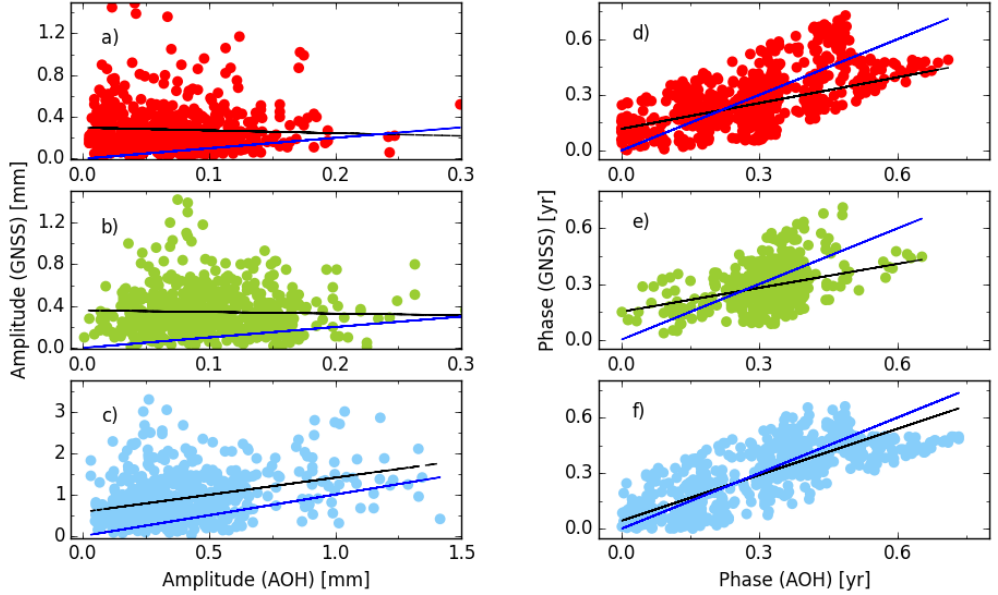
Figure 8. The agreement performance of semi-annual signal between GNSS and AOH, ( a , d ) for east; ( b , e ) for north; ( c , f ) for vertical component. The phase is divided by 4π and to keep the absolute phase difference less than 0.25 year, the values out of the range from − 0.25 to 0.25 year are added by 0.5 year and not used for fitting.